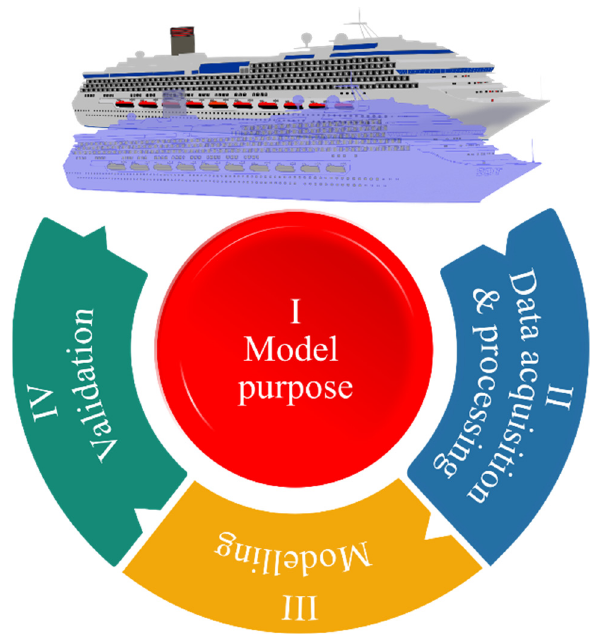
Figure 1. SDT concept as an iterative